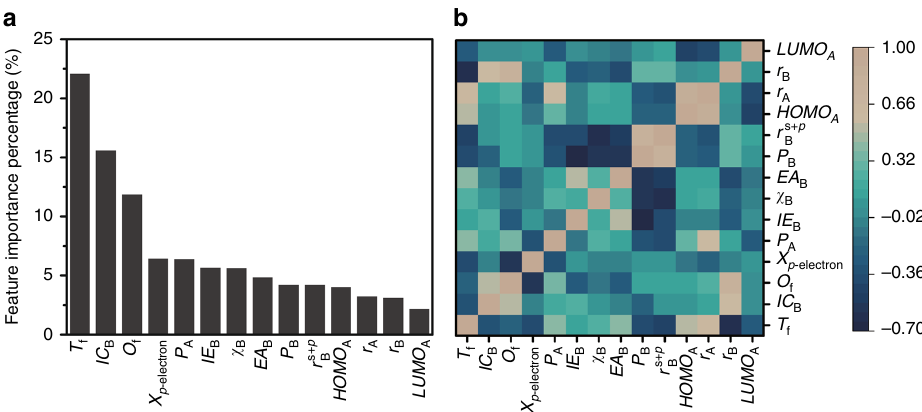
Fig. 3 Importance and correlation of the selected features. a The 14 selected features are ranked using GBR algorithm. b The heat map of Pearson correlation coef fi cient matrix among the selected features for GBR algorithm evolves from the combination of boosting